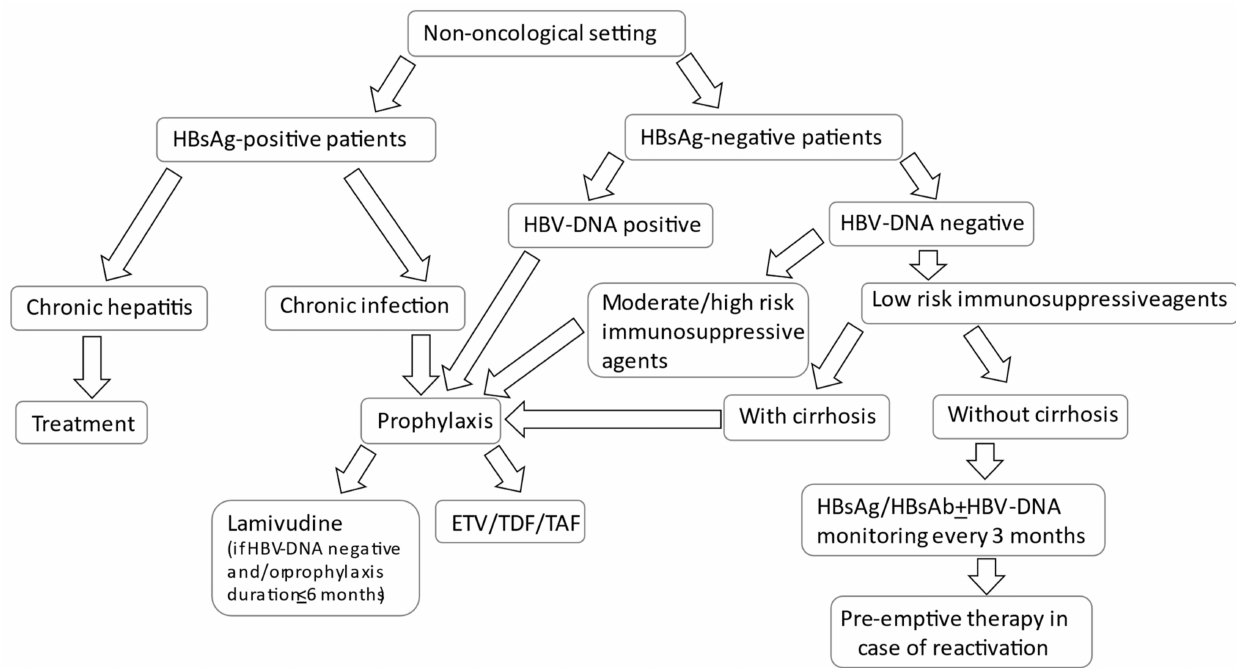
Figure 1. Algorithm of HBVr management in patients undergoing immunosuppression for non-oncological